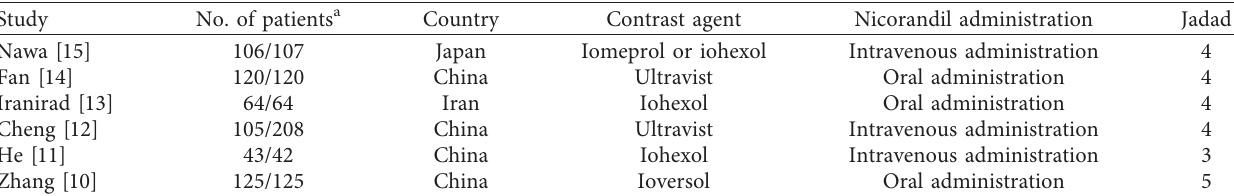
Table 1: Characteristics of each included trials.